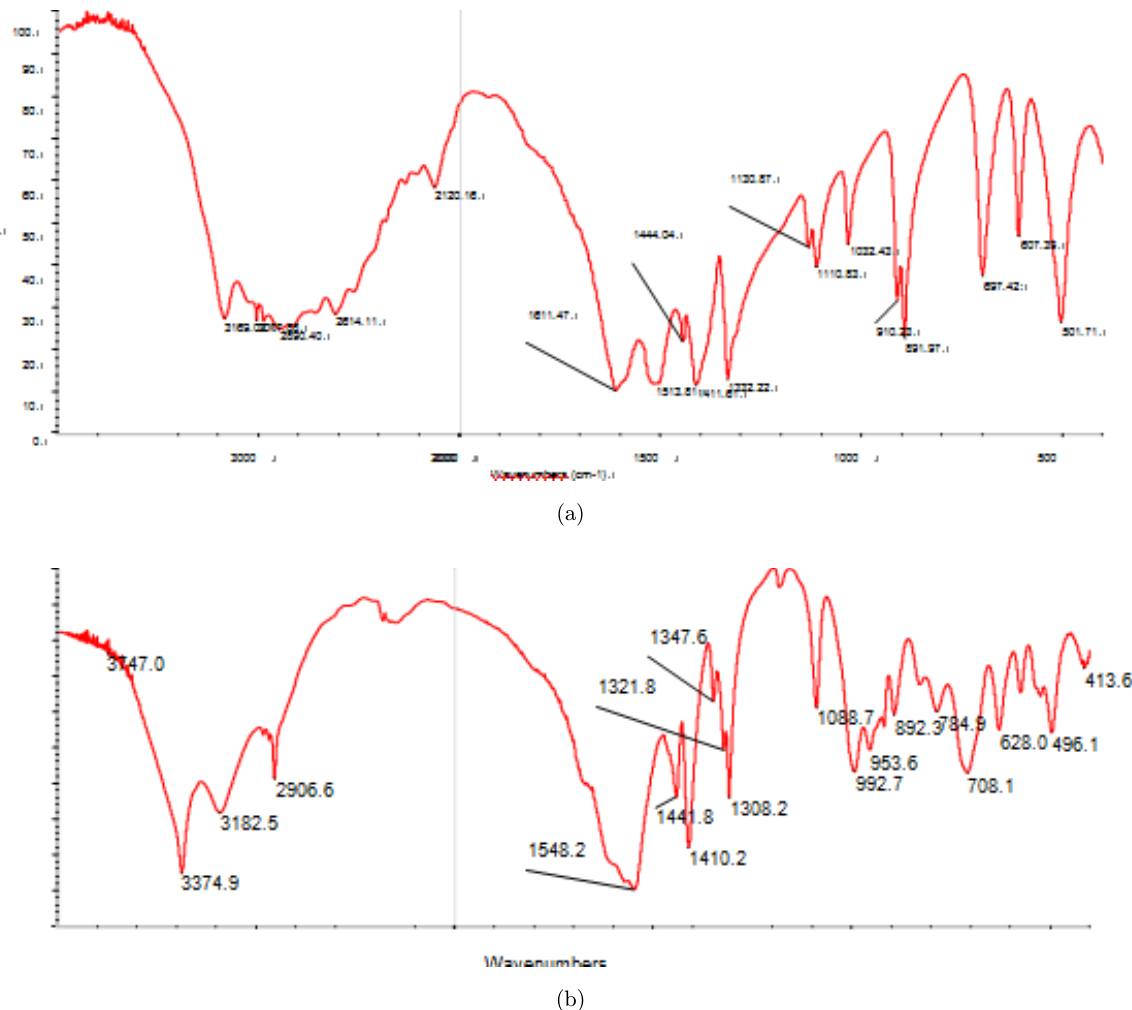
Fig. 2. The infrared spectrum of glycinate (a), calcium glycinate (b), magnesium glycinate (c), and zinc glycinate